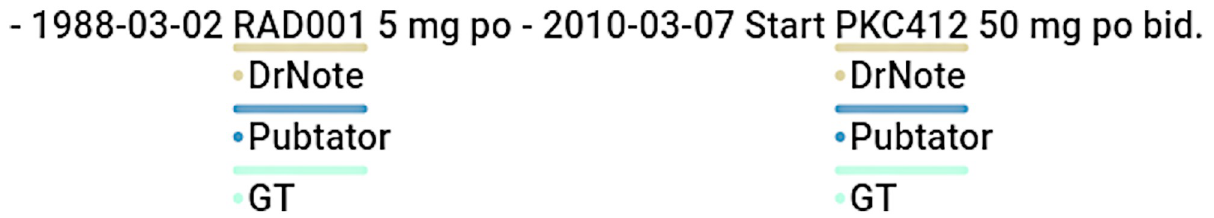
Fig 6. Comparative Sample 4. Weakness of cTAKES to detect certain codes ( RAD001 , cTAKES).